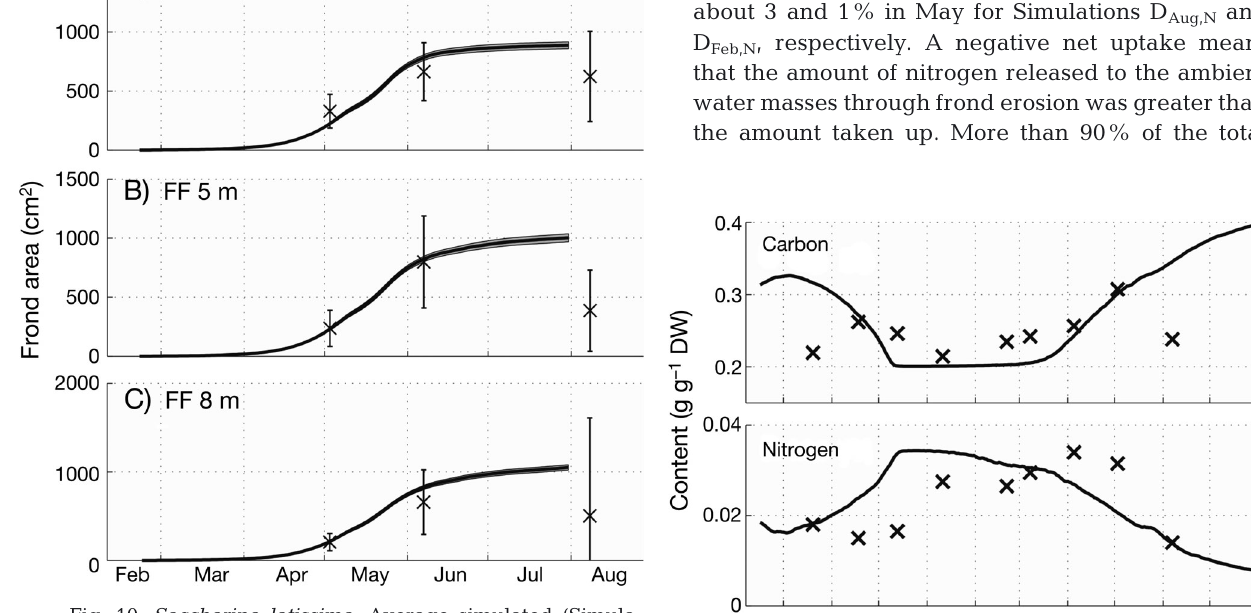
Fig. 10. Saccharina latissima . Average simulated (Simula- tion B Feb,N , continuous lines) and measured (crosses) frond areas (cm 2 ) for the February deployment at the fish farm (FF) station (Fig. 1B) at (A) 2 m, (B) 5 m and (C) 8 m depth. The shaded regions and error bars indicate standard deviations of simulated and observed values, respectively